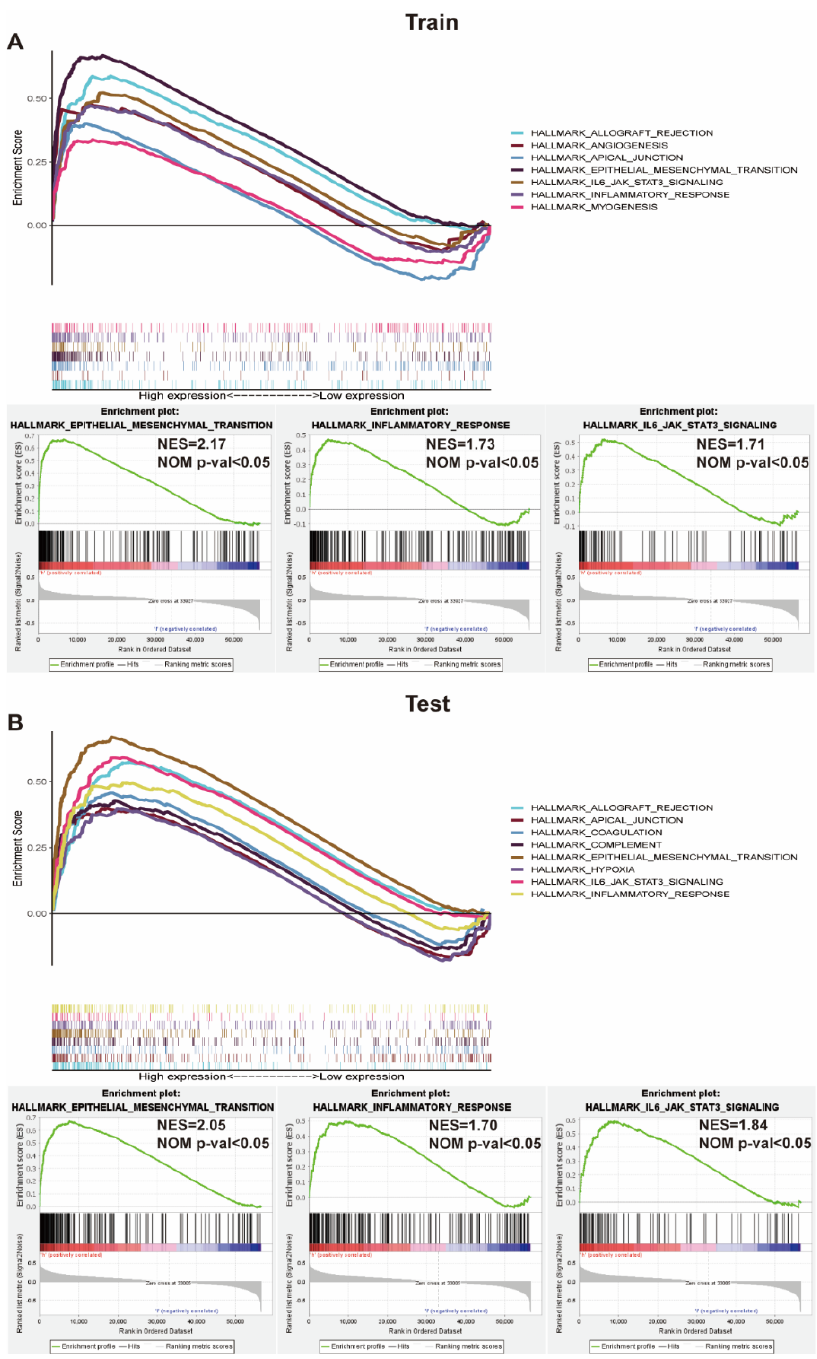
Figure 6. GSEA enrichment analysis between high and low risk groups. ( A ) The hallmark enrichment of high and low risk groups by GSEA method; GSEA revealing that genes in the high risk group were enriched for hallmarks of epithelial–mesenchymal transition (EMT) and immune response in train cohort; ( B ) The results were further validated by the test cohort.